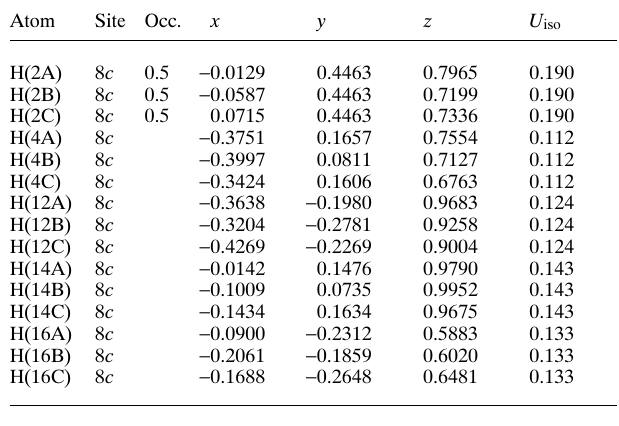
Table 3. Atomic coordinates and displacement parameters (in Å 2 ) .